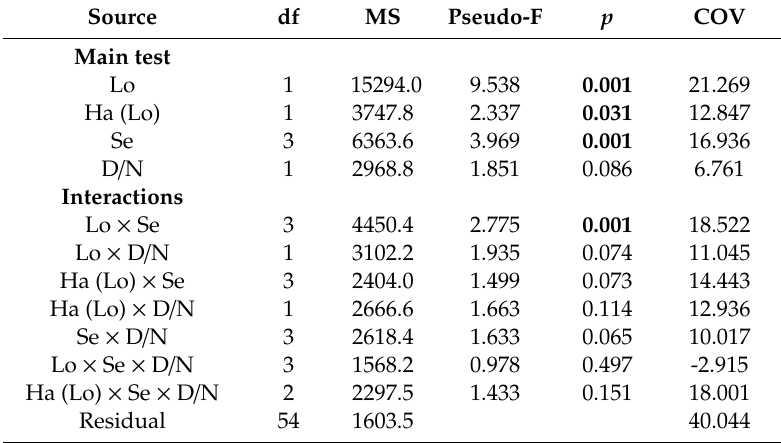
Table 3. Mean squares (MS), pseudo-F ratios, significance levels ( p ), and components of variation (COV) for PERMANOVA tests using Bray–Curtis similarity matrices from abundance of decapod assemblages showing di ff erences in location (Lo), habitat (Ha nested within Lo), season (Se), day / night (D / N), and interactions terms; bold letters indicate significance at p < 0.05.